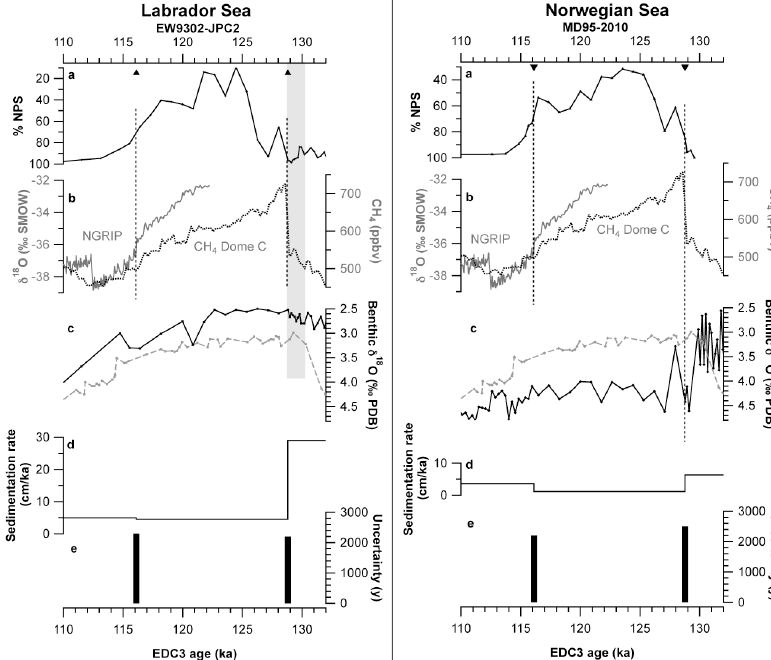
Figure 6: Definition of the age model of the two cores from the Labrador Sea (left panel) and the Norwegian Sea (right panel). (a) Percentage of the polar species N. pachyderma sinistral (%NPS) (black line) from (left panel) core EW9302-JPC2 from the Labrador Sea (Rasmussen et al., 2003a), and (right panel) core MD95-2010 from the Norwegian Sea (Risebrobakken et al., 2005). (b) (all panels) Greenland NGRIP ice δ 18 O record (North Greenland Ice Core Project members, 2004) (grey line) and Antarctic EDC methane record (Loulergue et al., 2008) (grey dotted line). (c) Benthic δ 18 O record from (left panel) core EW9302-JPC2 (black line) (Rasmussen et al., 2003a) and from (right panel) core MD95-2010 (black line) (Risebrobakken et al., 2005), in comparison to the benthic δ 18 O record of the North Atlantic core ODP 980 (grey dashed line) (Oppo et al., 2006). (d) (all panels) Sedimentation rate variations. (e) (all panels) Age uncertainty of the defined tie-points (see Table 4 for details). Tie-points are indicated by triangles in (a) , and highlighted by the vertical dotted lines. The grey shaded area in the left panel highlights the diatom mat at the onset of the LIG (Rasmussen et al., 2003a).